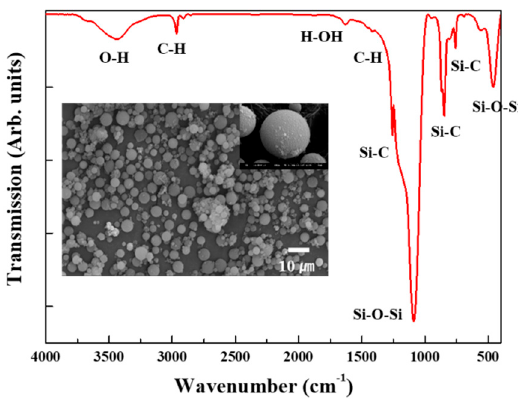
Figure 1. FT-IR spectra of the starting silica aerogel powder. The inset is an SEM image of the starting silica aerogel powder.